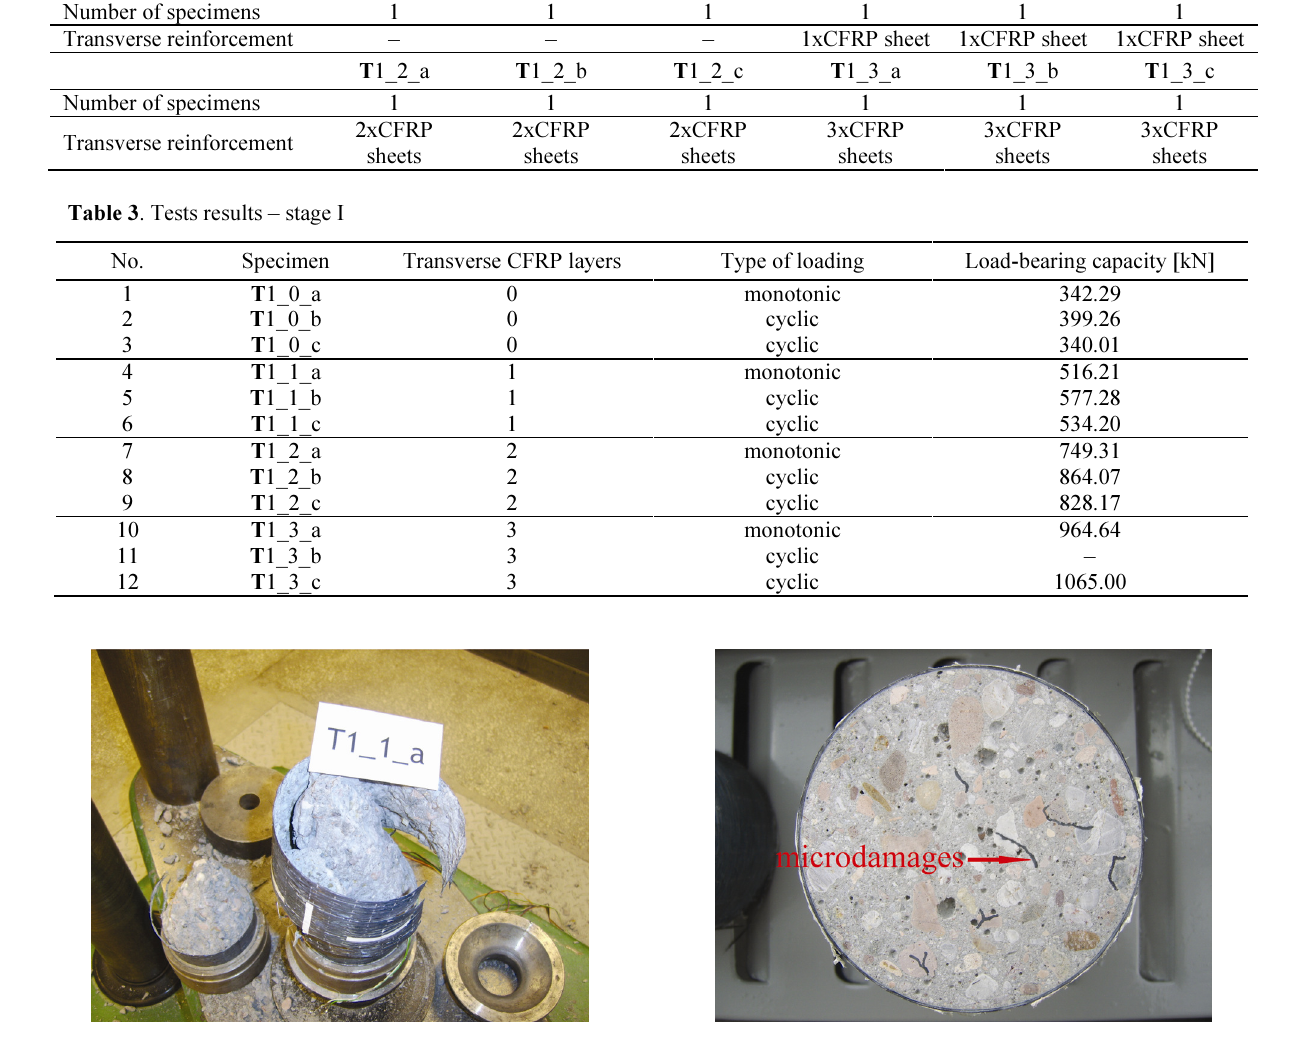
Fig. 5. Typical failure of CFRP confined concrete cylinders Fig. 6. View of specimen T 1_3_b after cross-cut in the half of